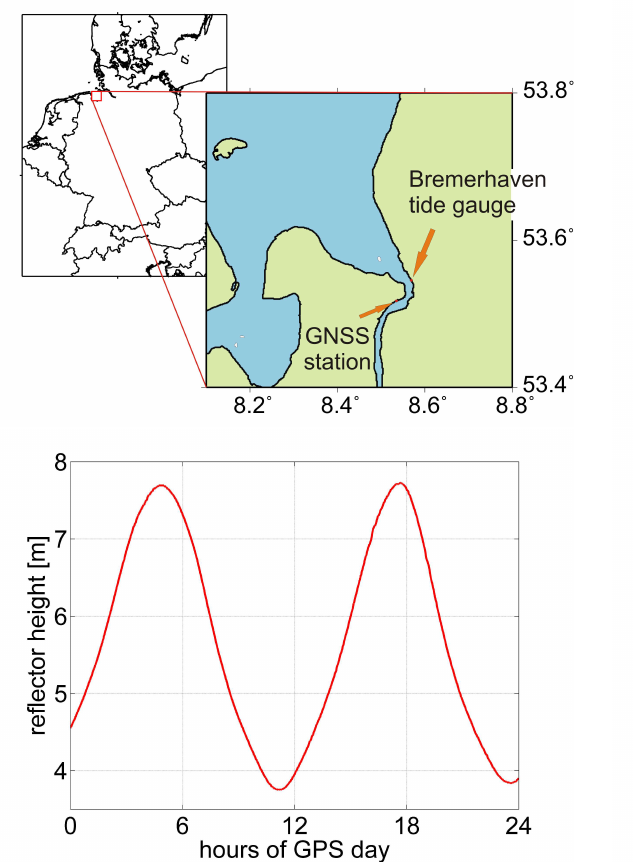
Figure 3: GNSS site and tide gauge in Bremerhaven (top) and calcu- lated reflector height at the GNSS site (bottom).